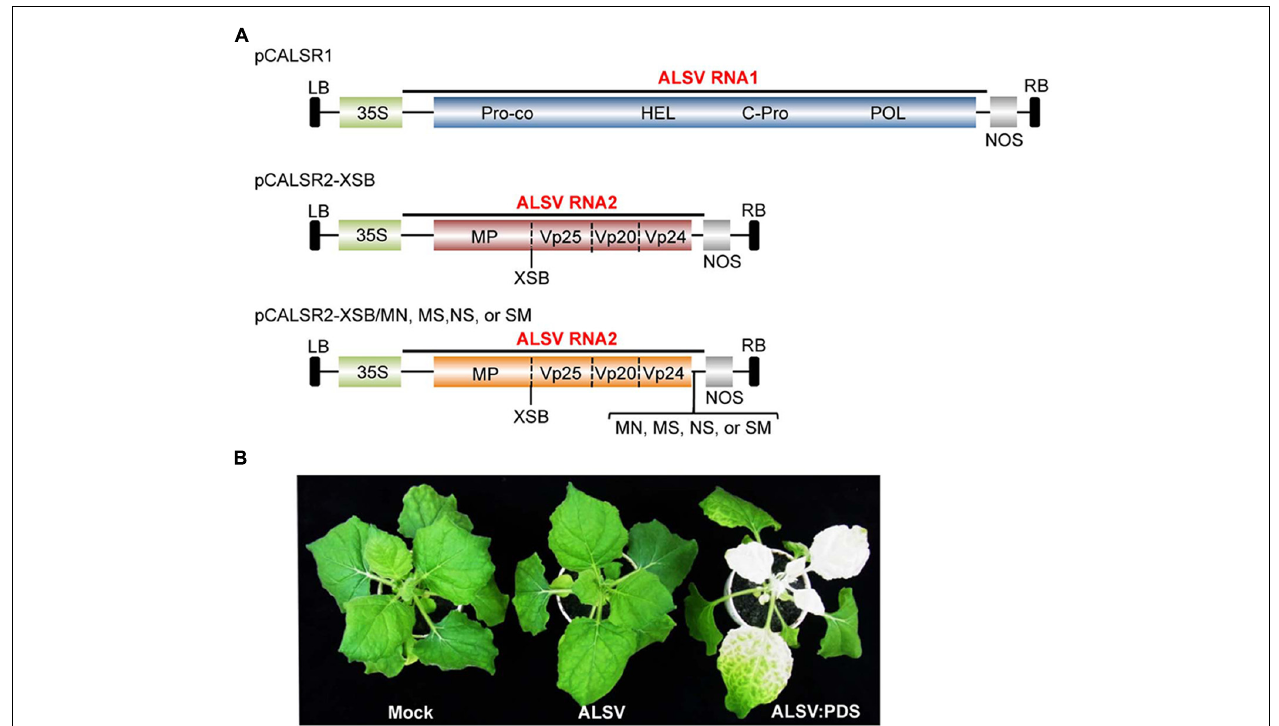
FIGURE 1 | Schematic representation of infectious clones of ALSV RNAs and infectivity of ALSV-based vector in N. benthamiana plants. (A) The infectious ALSV RNA1 and RNA2 cDNA sequences (Li etal., 2004) were respectively, introduced between the CaMV 35S RNA promoter (35S) and the nopaline synthase terminator (NOS) within the left and right borders (LB and RB) of the pCAMBIA1300 binary vector to produce pCALSR1 and pCALSR2-XSB. Restriction sites ( Mlu I- Nco I [MN], Mlu I- Sal I [MS], Nco-Sal I [NS], and Sal I- Mlu I [SM]) were respectively, introduced into pALSR2-XSB immediately downstream of the translation stop codon of the 108K open reading frame to generate pCALSR2-XSB/MN, pCALSR2-XSB/MS, pCALSR2-XSB/NS, and pCALSR2-XSB/SM. The target genes can be cloned into the Xho I, Sma I,